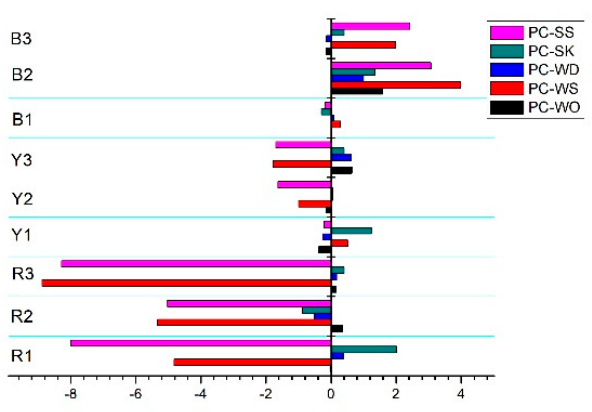
Figure 6. Δ a* calculated using PC adjustment as the target and the other procedures as samples.